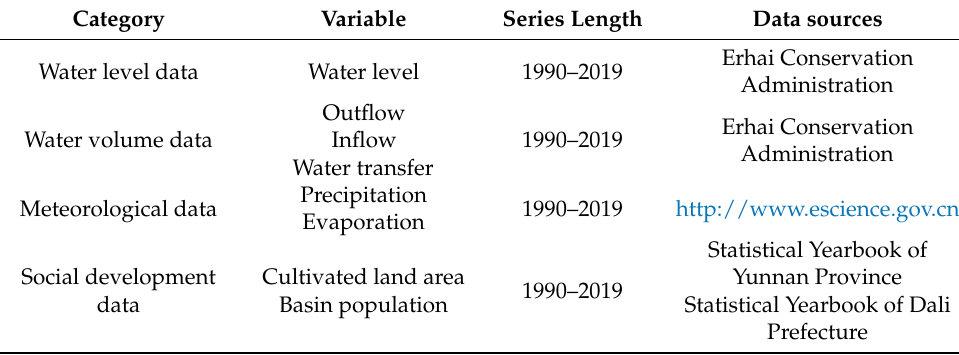
Table 1. List of basic analysis data.